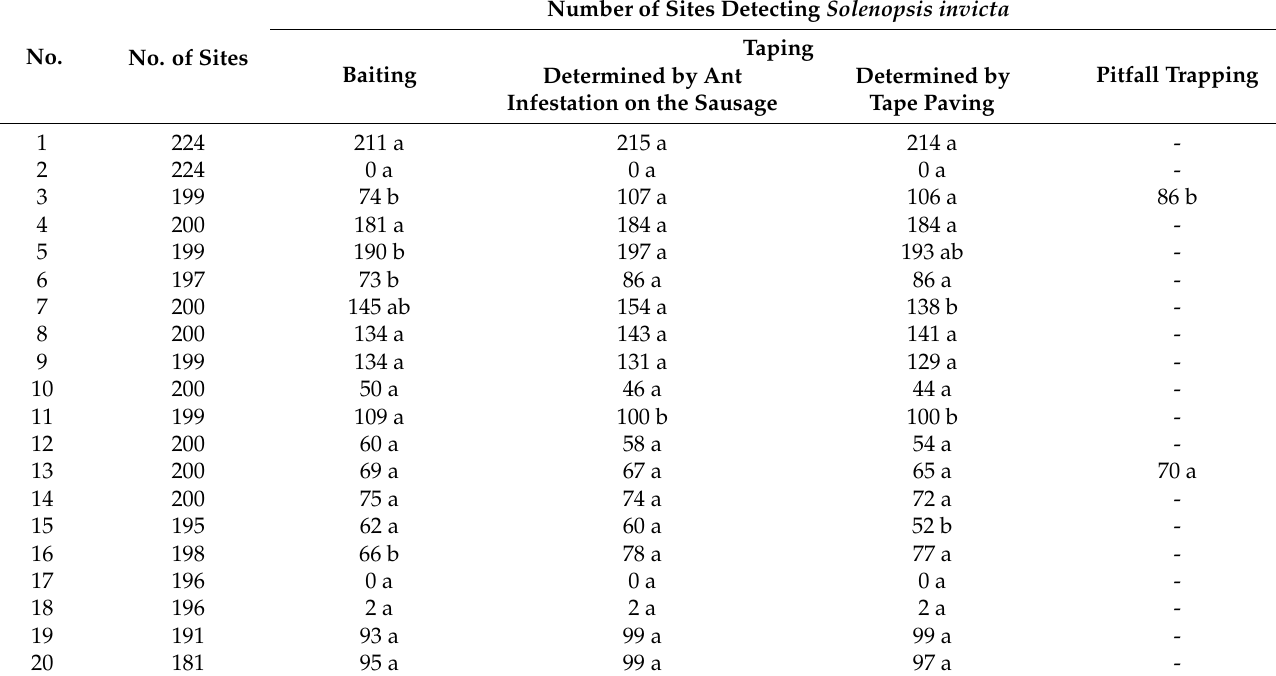
Table 1. Number of monitors (bait, tape, or pitfall trap) detecting Solenopsis invicta at each location. “-” indicates pitfall traps were not tested in the location. Different letters within the same row indicate significant differences ( p < 0.05). Statistical results are shown in Supplementary Material: Table